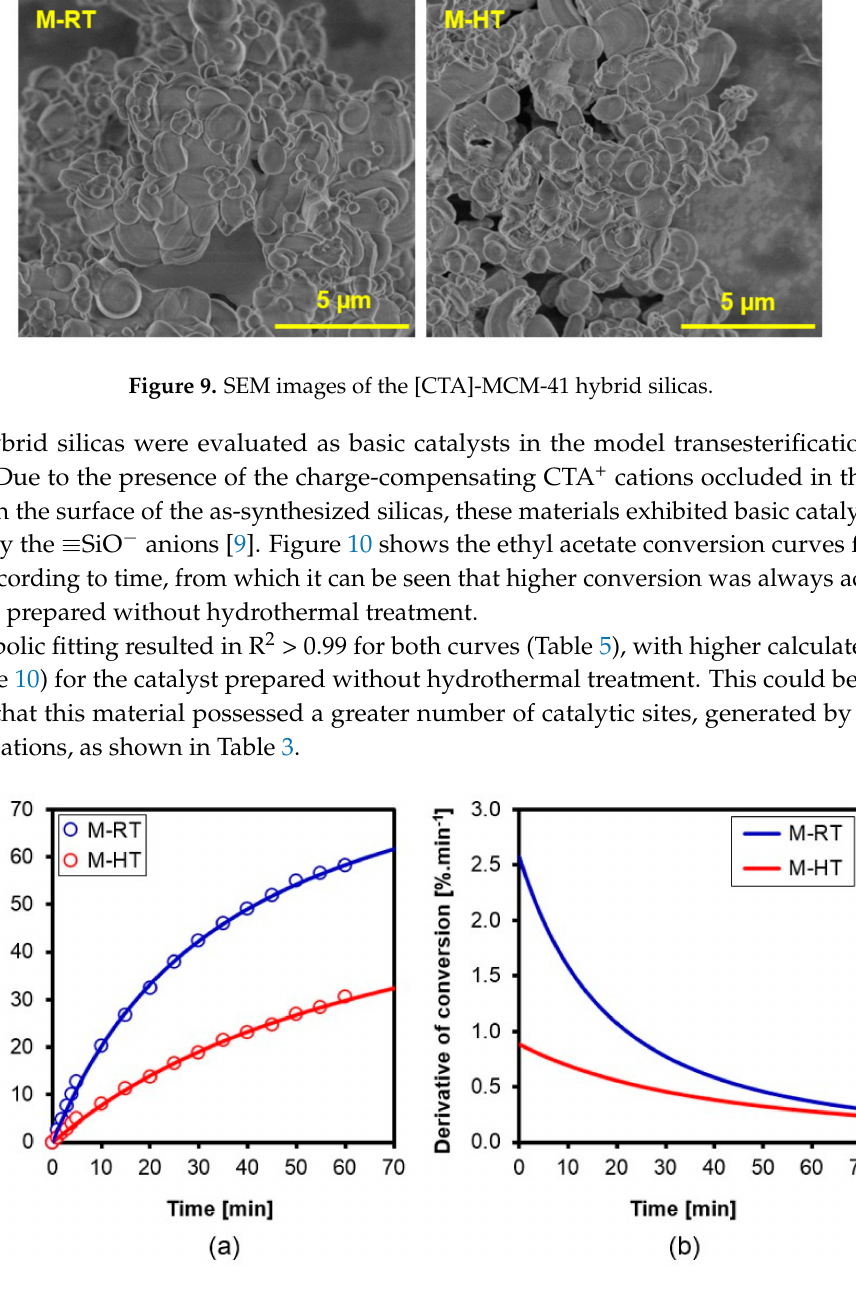
Figure 10. Conversion ( a ) and derivative conversion ( b ) curves for the [CTA]-MCM-41 hybrid silicas used in ethyl acetate